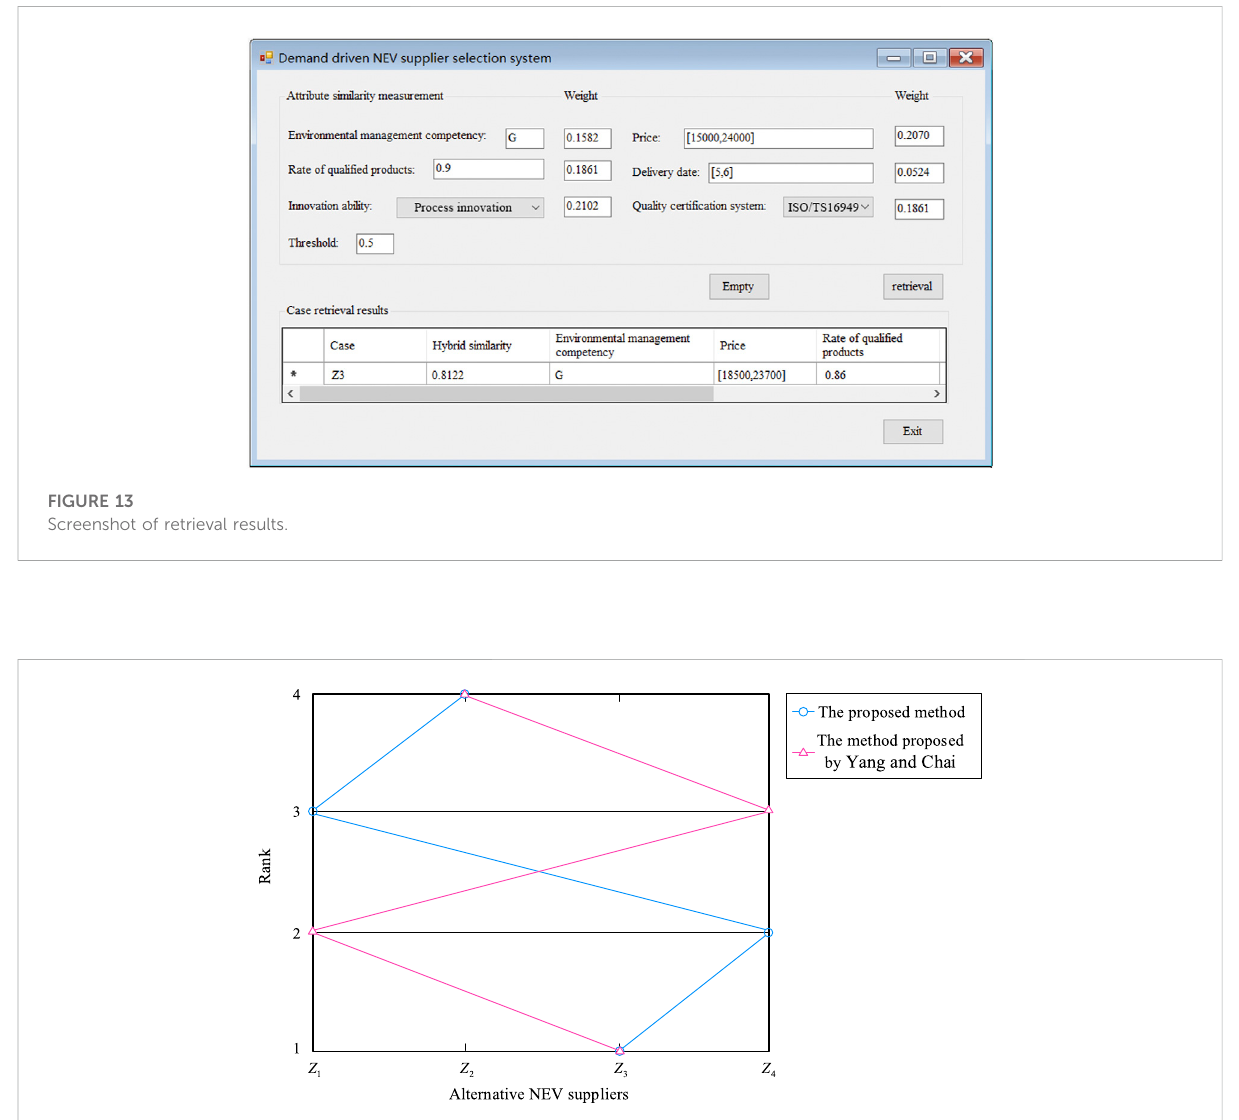
FIGURE 14 Ranking of the alternative NEV suppliers obtained by different